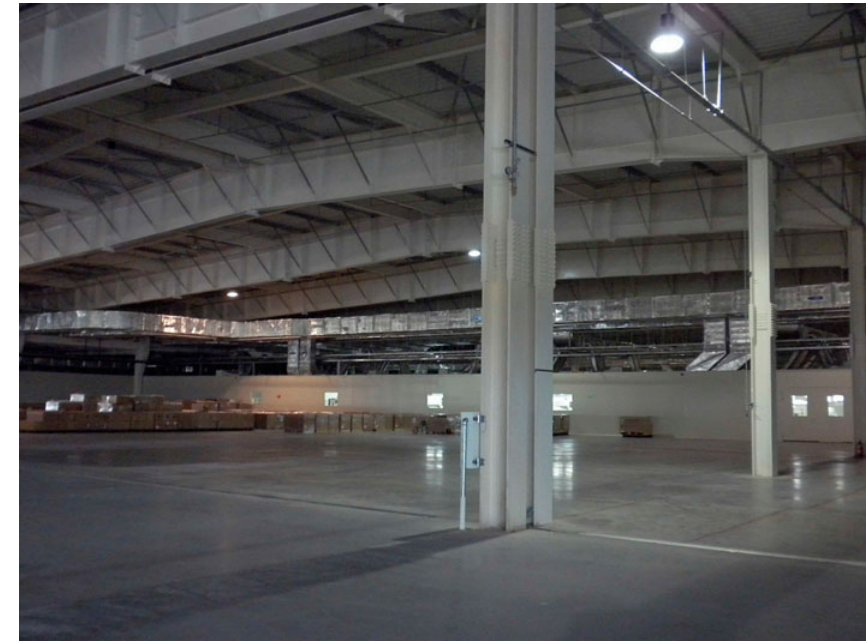
Fig. 1. General view of steel-bearing structure of the industrial hall